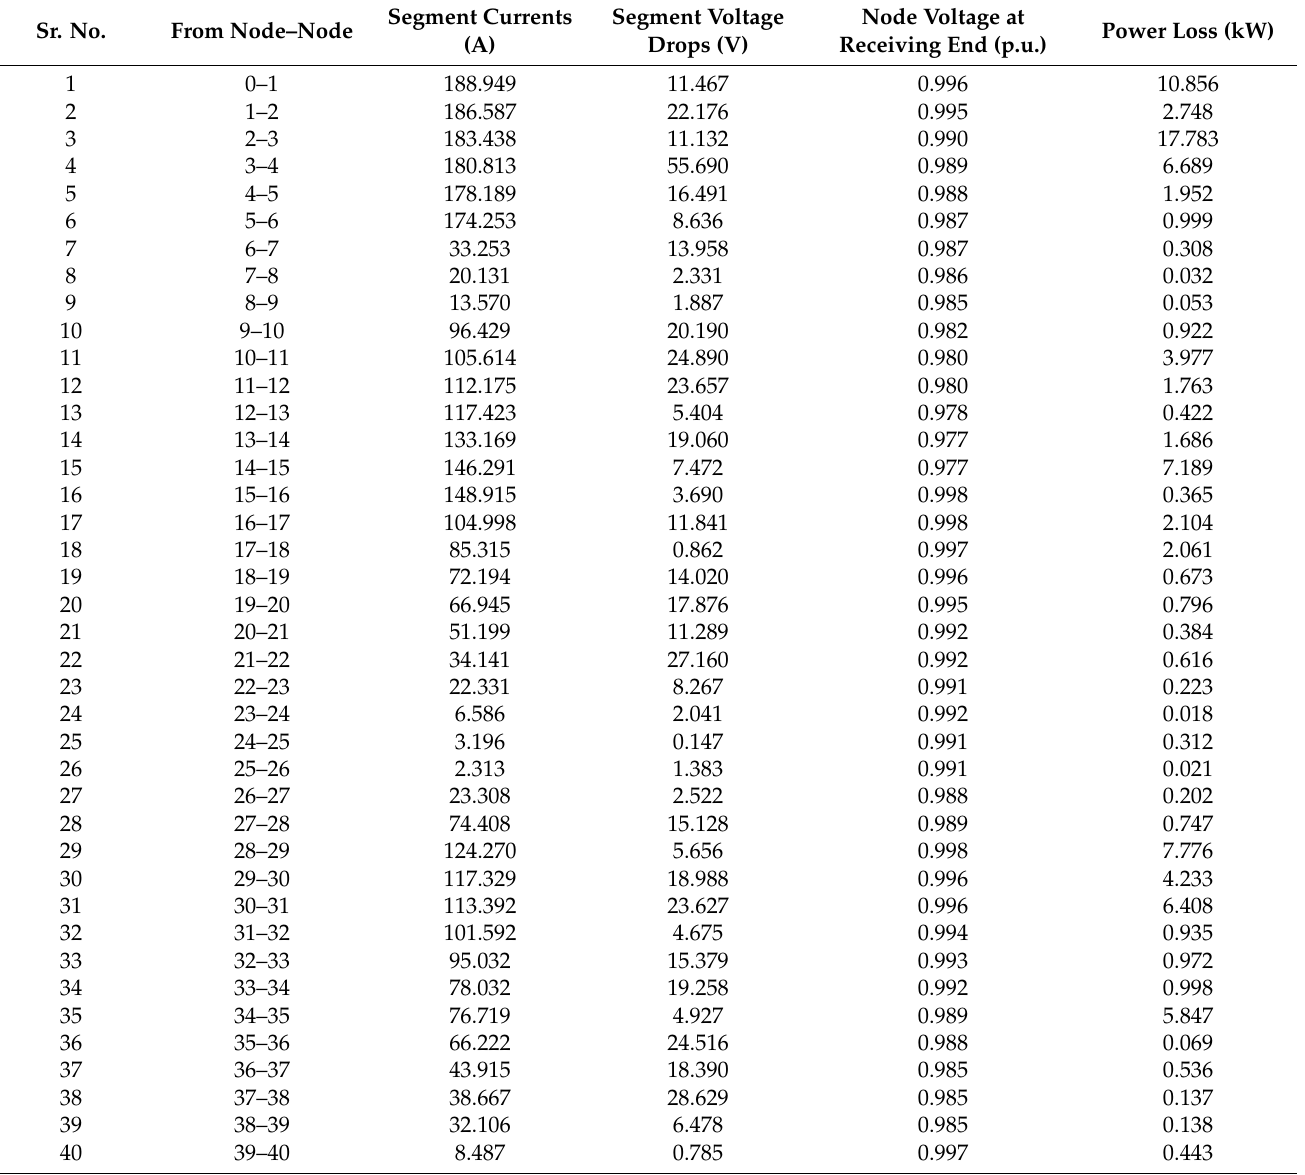
Table 4. Load flow results for DN with optimal DGs through ETAP.